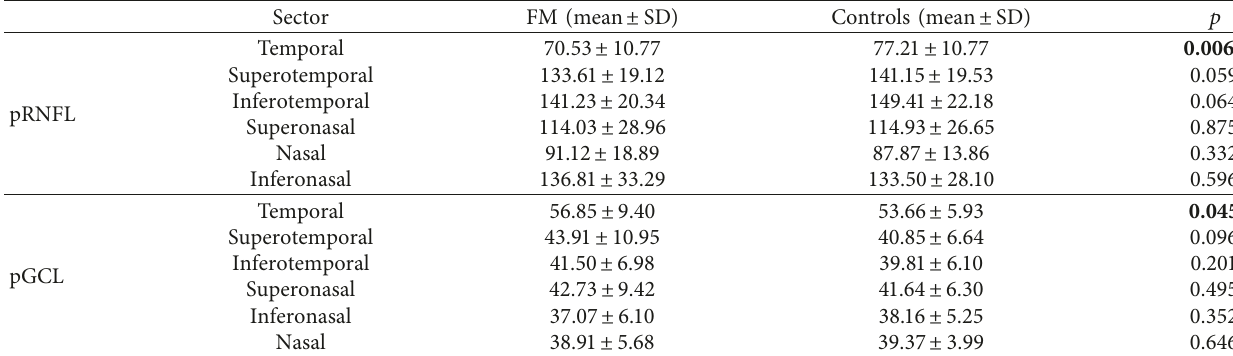
Table 2: Peripapillary measurements (in microns) of the retinal nerve fiber layer and the ganglion cell layer in patients with fibromyalgia and healthy controls using swept-source Triton optical coherence tomography. Bold numbers indicate p < 0 . 05, the asterisk indicates significant values according to Bonferroni corrections ( p < 0 .